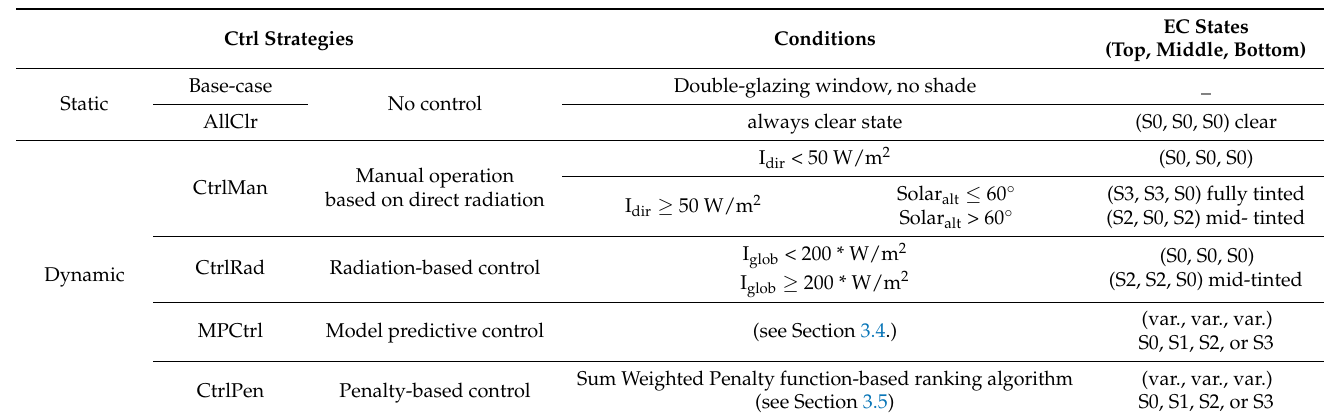
Table 5. Various control strategies were used in this